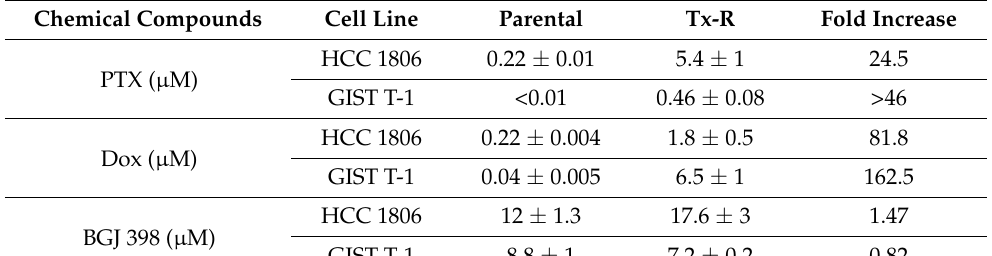
Table 1. IC 50 values for PTX and Dox in parental and Tx-R triple-negative breast cancer (TNBC) and gastrointestinal stromal tumor (GIST) cell lines.